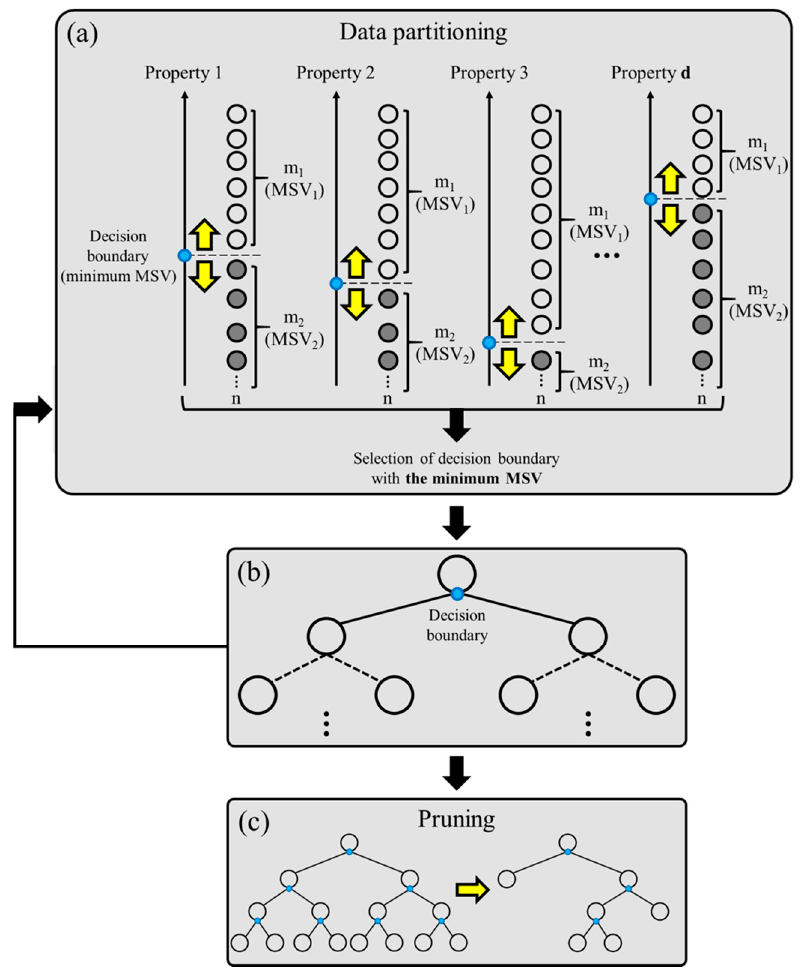
Figure 4. Construction of a decision tree with recursive partitioning and pruning based on n sample data of the d property [16]. ( a ) Search for decision boundary to minimize data impurity; ( b ) make branches out with decision boundaries; ( c ) remove excessive branches according to user-set standard.